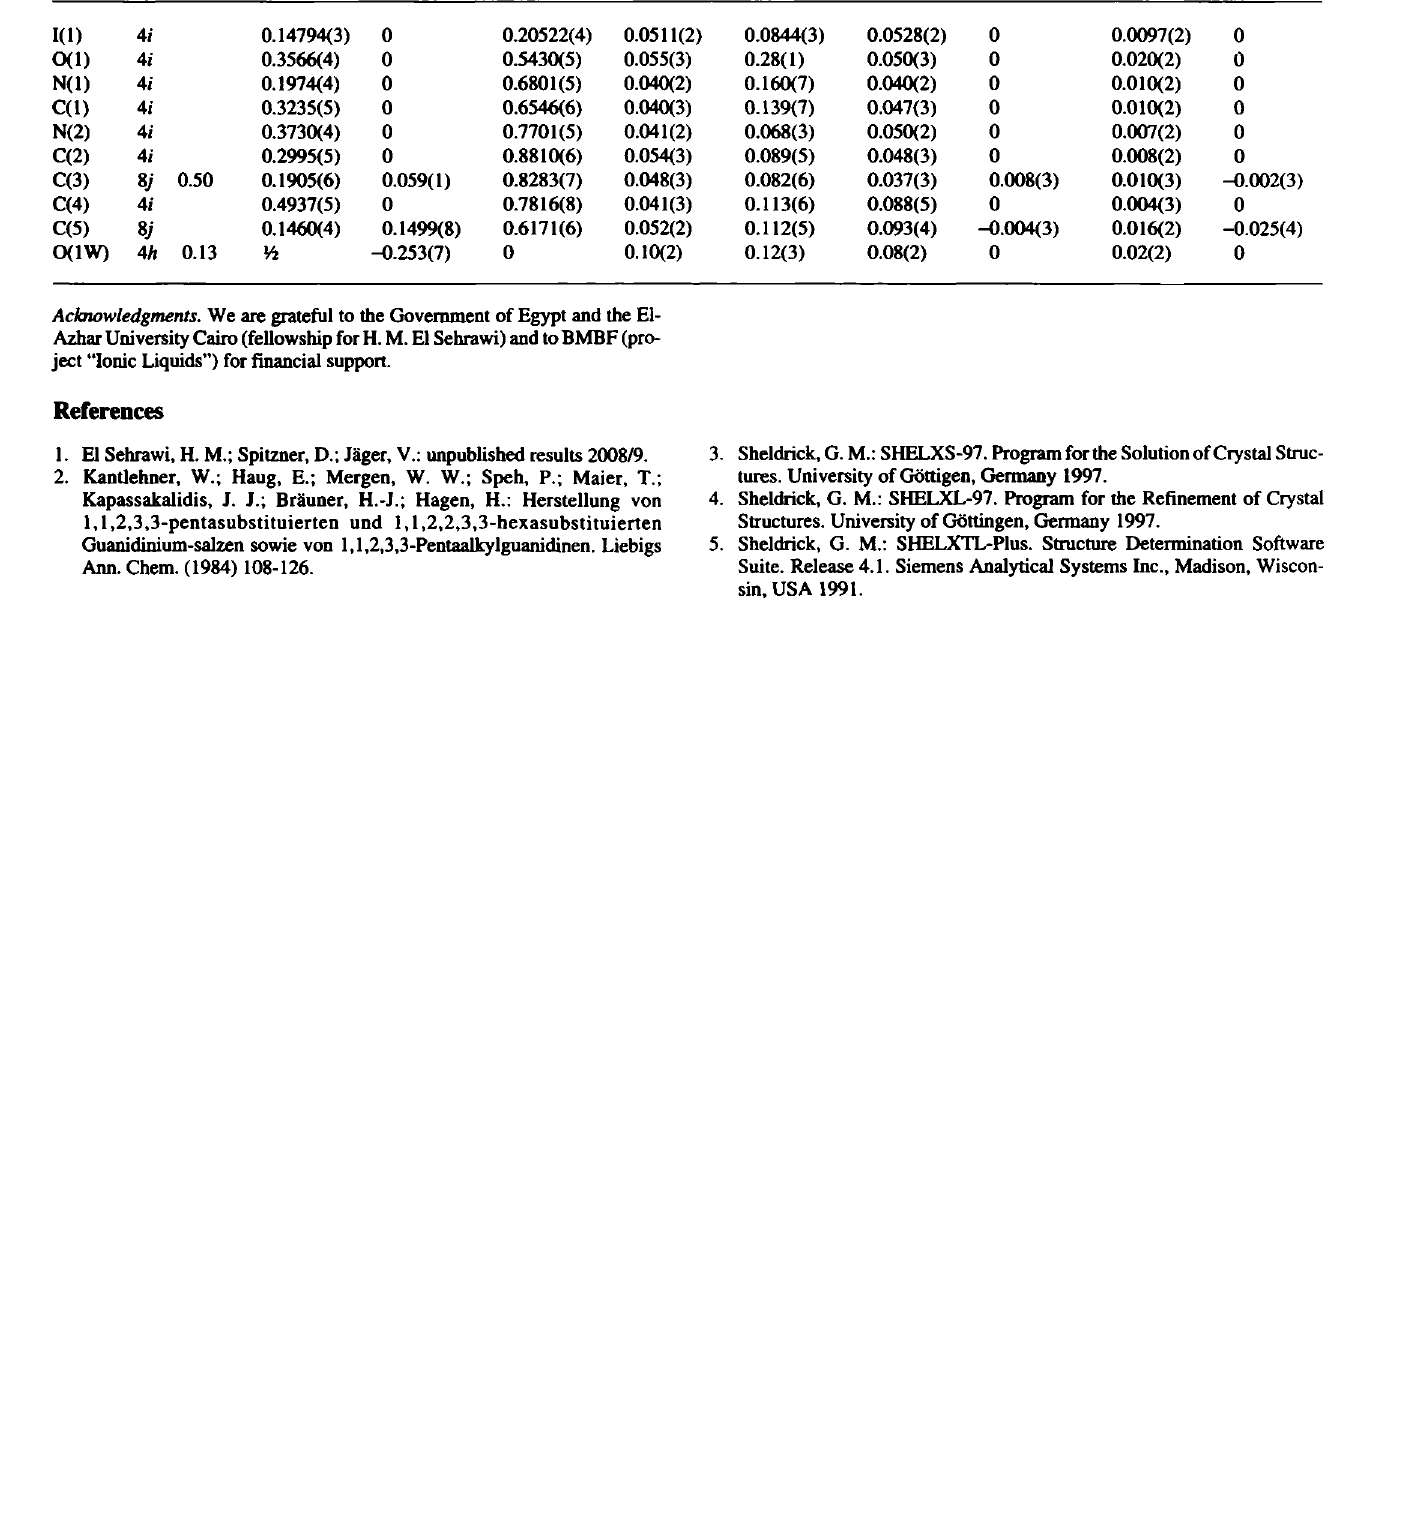
Table 3. Atomic coordinates and displacement parameters (in Â 2 ). Site